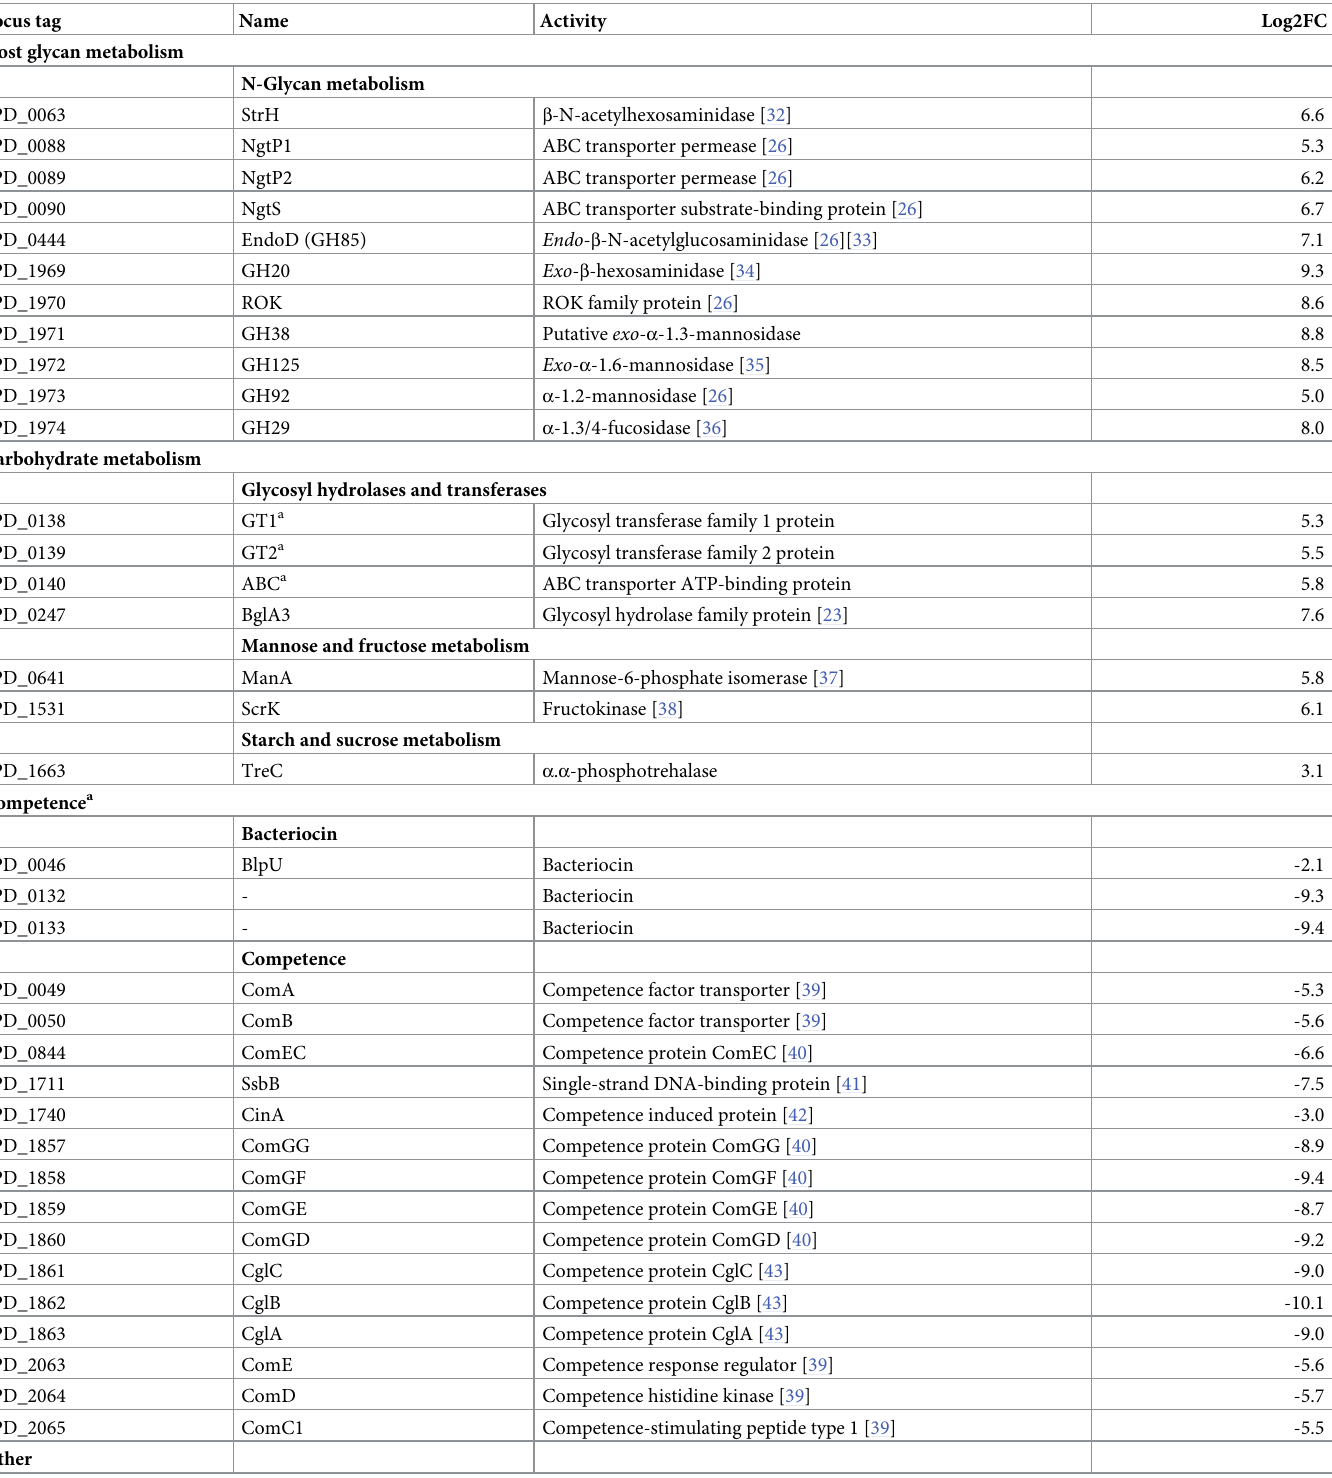
Table 1. List of up- and downregulated genes when overexpressing RR07. Protein activities were attributed based on information retrieved from the KEGG and Uni- prot databases as well as literature searches. See Fig 1 for criteria of up- and downregulated genes. a names given for convenience in model illustration (Fig 9). a our experi- ments suggest that the decrease of competence gene expression is due to an artefact from overexpression of RR07. Locus